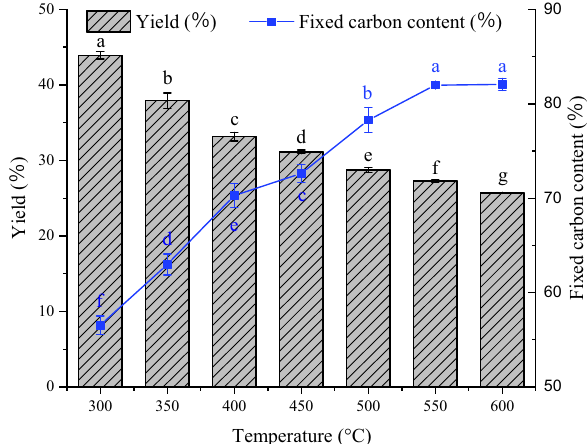
Figure 1: E ff ect of temperature on yield and fi xed carbon content of biochar. Bar plots and points are indicated as mean of three repli - cates and vertical bar indicates ± SE. Di ff erent letters indicate sig - ni fi cant di ff erences between treatments at P < 0.05.